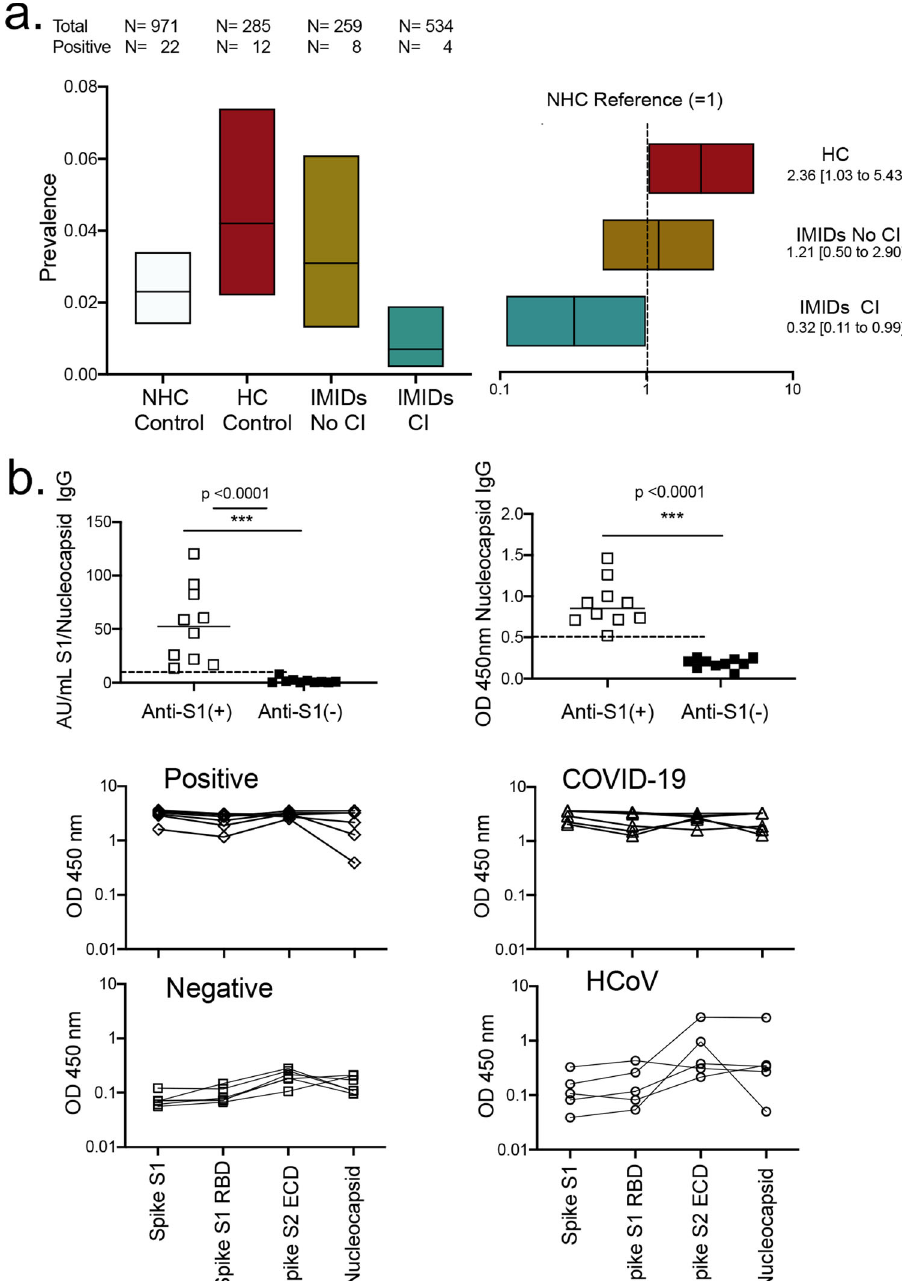
Fig. 1 Prevalence of anti-SARS-CoV-2 IgG antibodies across study groups and validation of the results. a Left: Prevalence and 95% con fi dence intervals of a positive anti-SARS-CoV-2 IgG antibody test recognizing the S1 domain of the spike protein in the non-health care (NHC) control cohort, health care (HC) control cohort and immune-mediated in fl ammatory diseases (IMIDs) with and without cytokine inhibitors (CI); right: risk ratios and 95% con fi dence intervals of anti-SARS-CoV-2 IgG antibody positivity in the HC control cohort and IMIDs with and without cytokine inhibitors (CI) with the NHC control cohort as reference; b Comparison of anti- SARS-CoV-2 IgG positive (anti-S1 + ; N = 10) and negative (anti-S1; N = 10) samples (in Euroimmune ELISA) for reactivity in the chemi-luminescent anti- SARS-CoV-2 Spike S1/nucleocapsid IgG test (Yhlo Biotech) and anti-nucleocapsid IgG antibody ELISA (Immundiagnostik Inc). c Validation with in-house ELISA testing reactivities against 1 the S1 domain of the spike protein 2 , the receptor binding domain (RBD) of the S1 domain of the spike protein 3 , extracellular domain (ECD) of the S2 domain of the spike protein and 4 the nucleocapsid in anti- SARS-CoV-2 IgG negative ( N = 6) and positive ( N = 6) samples (in Euroimmune ELISA), COVID-19 patients with positive viral RNA test ( N = 6) and patients with endemic human coronavirus (HCoV) infection ( N = 5) in the pre- SARS-CoV-2